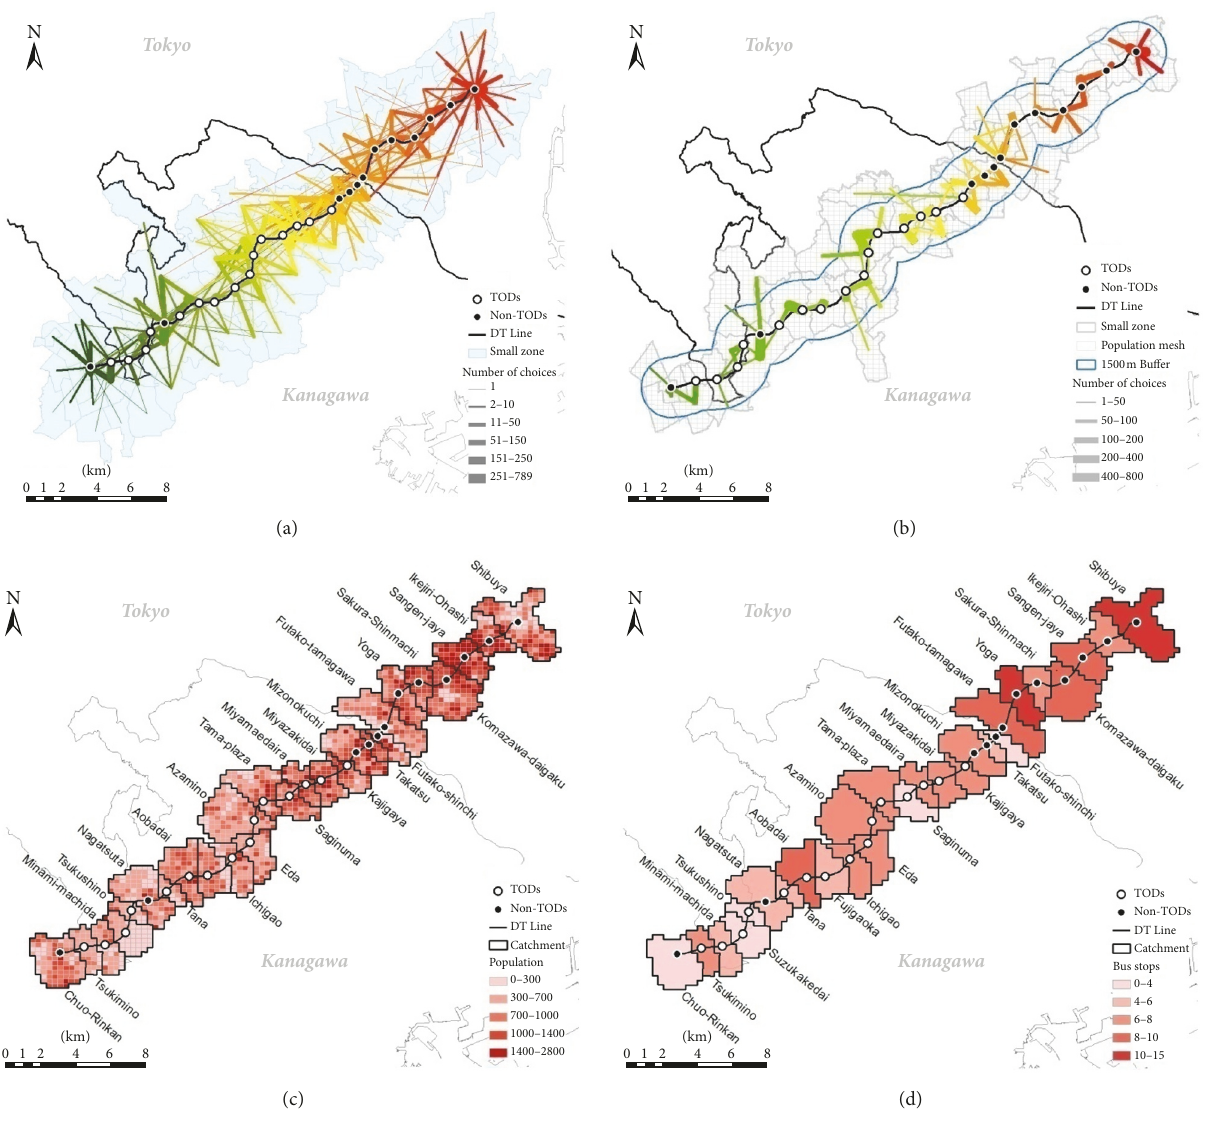
Figure 2: Generation of catchment area and distribution of a selected indicator for each catchment. (a) Original flow map; (b) deletion of extra zones and magnification; (c) finished catchment area; (d) bus stops for each catchment. Note . In (a) and (b), the flow color is used to distinguish the populations of different stations. The width of gray bar in legend represents the number of choices of separate